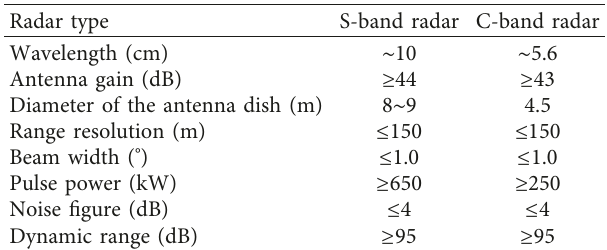
Figure 3: CINRAD coverage map (without beam blockage) of 230 km for S-band and 150km for C-band radar. White dots represent C- band radars, red dots denote the S-band radars, and black dots refer to national meteorological stations. Table 1: System specifications of China Next Generation Weather